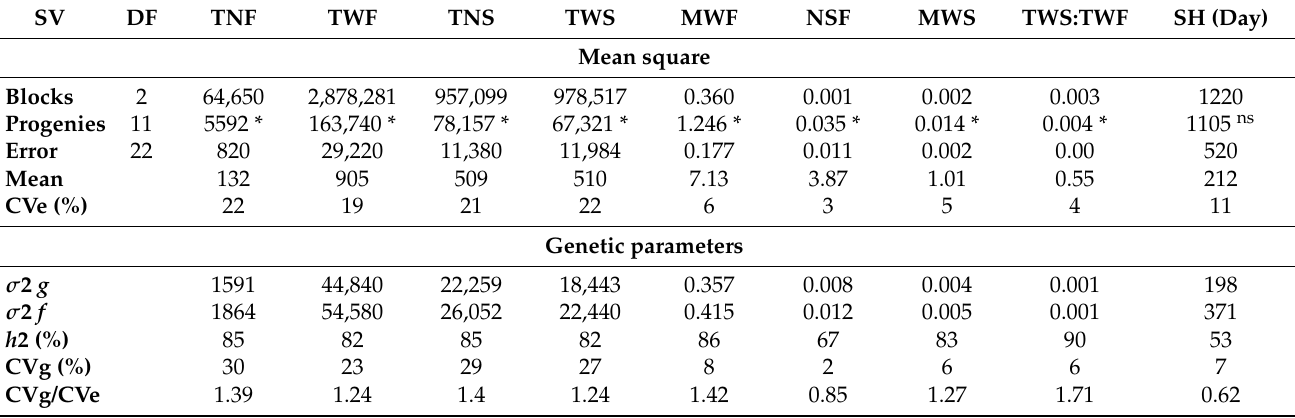
Table 2. Summary of analysis of variance (ANOVA) and genetic parameters for the fruit production and quality traits of 12 sacha-inchi